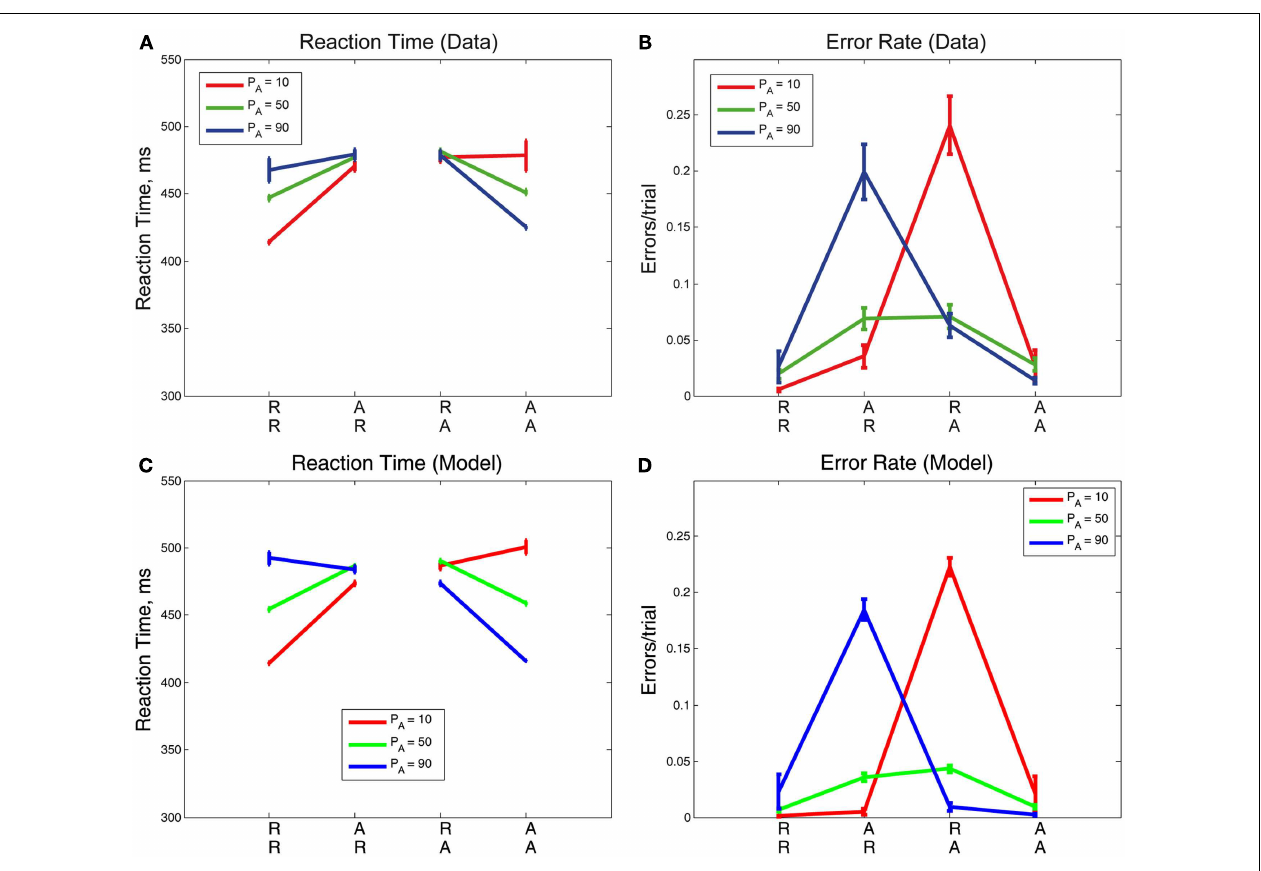
re-create behavioral trends in RTs and ERs but overestimate RTs for expected trials (RR, AA).The error bars in plots (A,B) represent the standard error of the mean, and in (C,D) the average value of standard error of the mean over 10 simulation runs (see Section 2.4 for